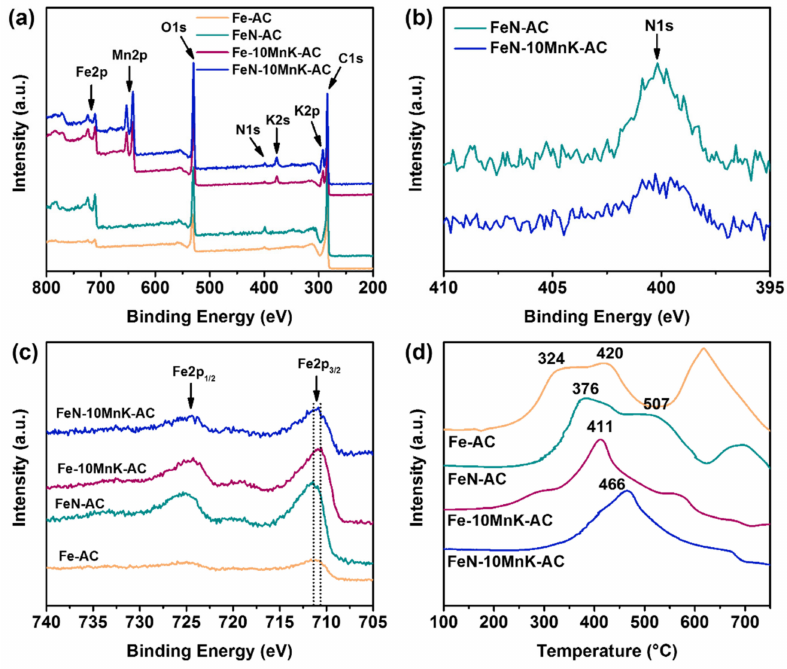
Figure 2. ( a ) XPS survey spectra of the Fe-AC, FeN-AC, Fe-10MnK-AC and FeN-10MnK-AC catalysts. The sharp photoelectron peaks at 712.1 eV (Fe2p), 642.2 eV (Mn2p), 531.1 eV (O1s), 378.0 eV (K2s), 294.1 eV (K2p), 285.0eV (C1s) and a weak photoelectron peak at 400.0 eV (N1s) are marked in the spectra. ( b ) High resolution XPS spectra of the N1s region for FeN-AC and FeN-10MnK-AC catalysts. ( c ) Fe2p XPS spectra and ( d ) hydrogen temperature programmed reduction (H 2 -TPR) profiles of